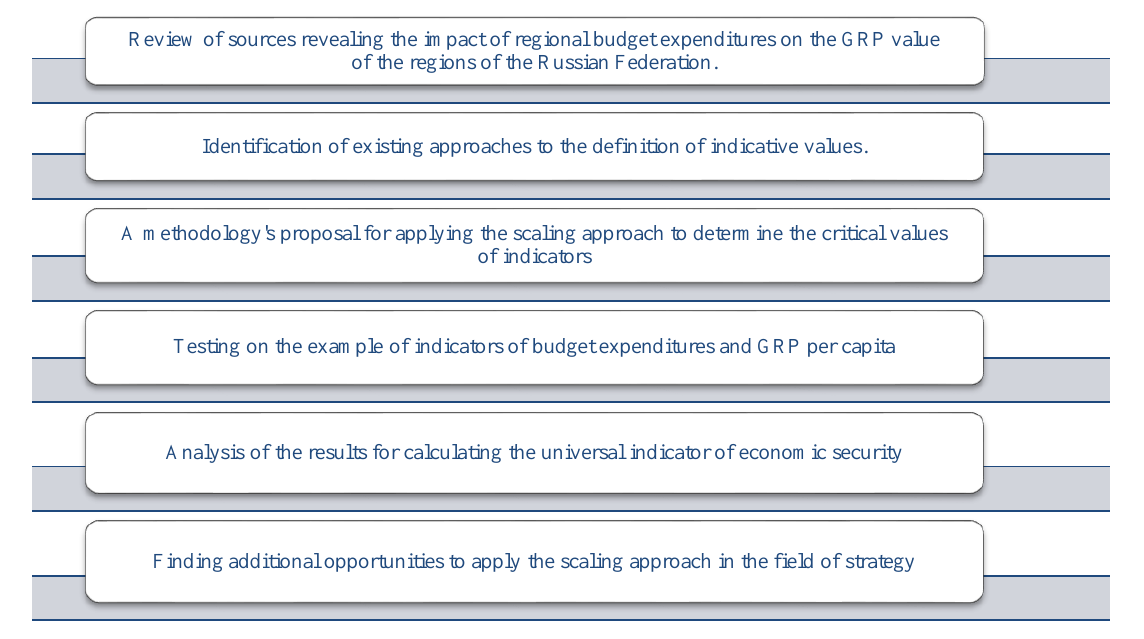
Figure 1. The methodologicalstudy flow